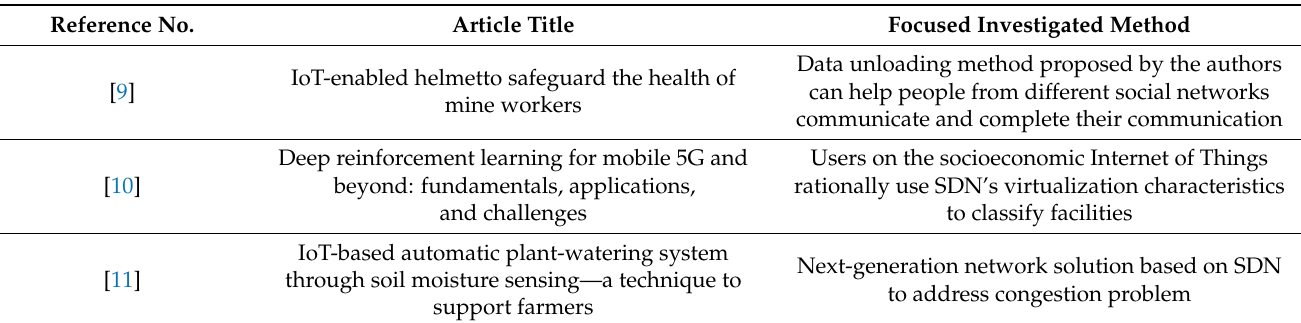
Table 1. Summary table of the related research findings. Reference